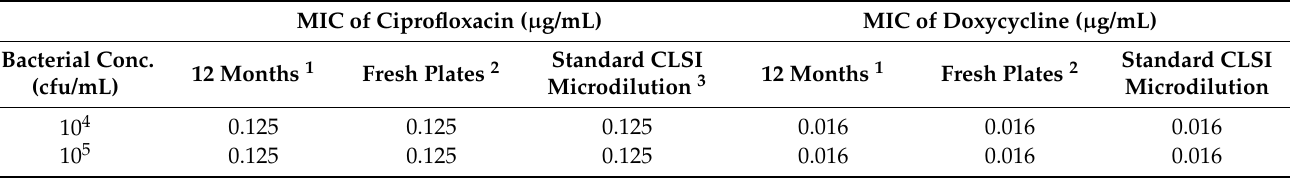
Table 1. Evaluation of MIC values for B. anthracis to ciprofloxacin and doxycycline after 12 months of